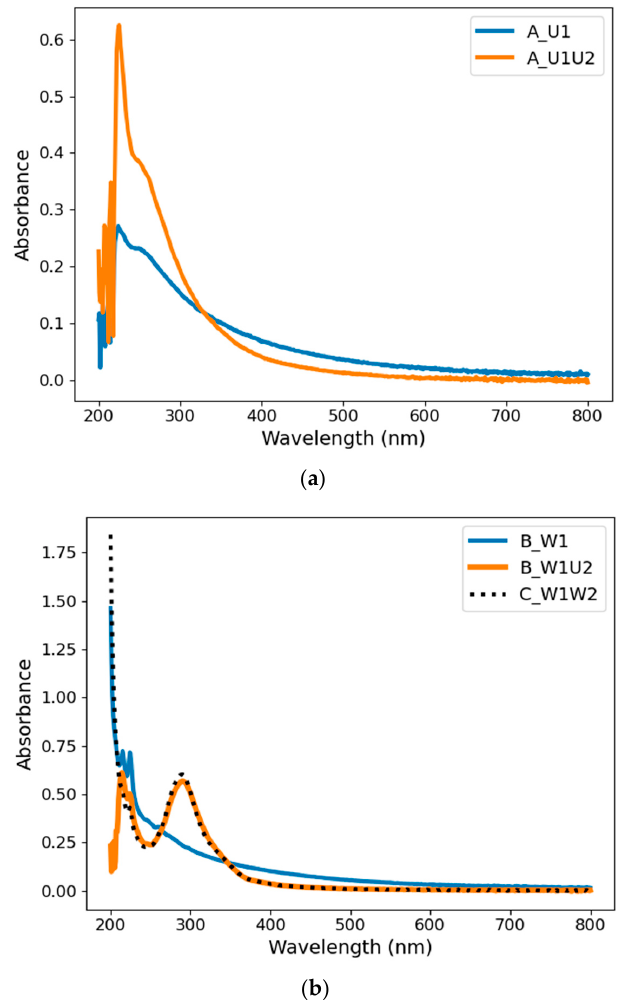
Figure 2. Absorbance spectra of CNPs obtained via Approaches ( a ) A and ( b ) B and